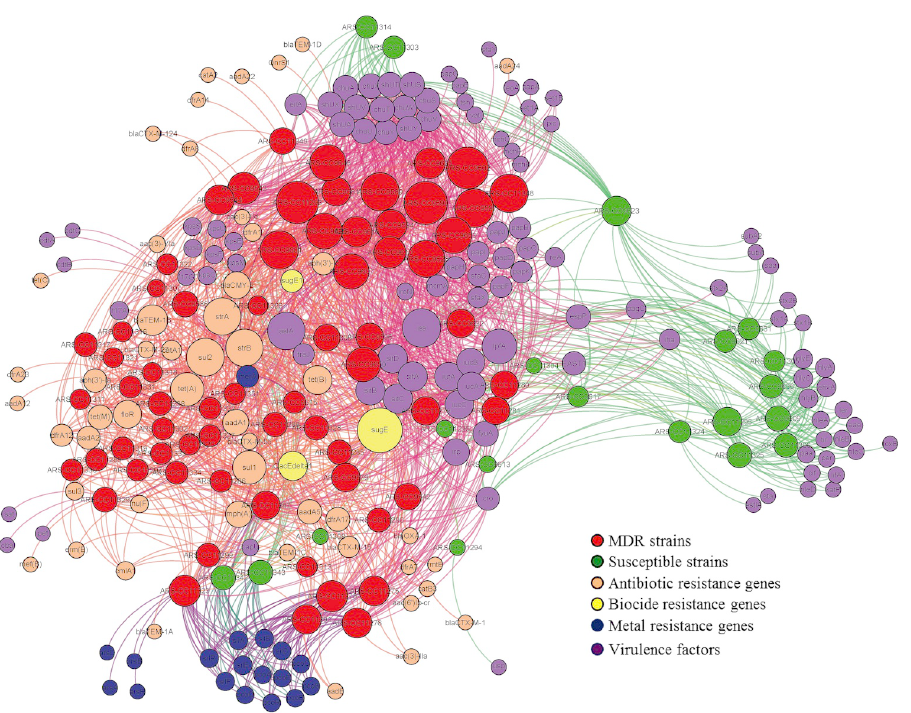
Fig 5. A network analysis showing the presence of resistance genes and virulence factors in all the isolates (both MDR and susceptible). The nodes are colored by the corresponding isolate and gene types. The size of each node represents the number of connected edges (degree). Each edge (curve) represents the presence of a gene in an